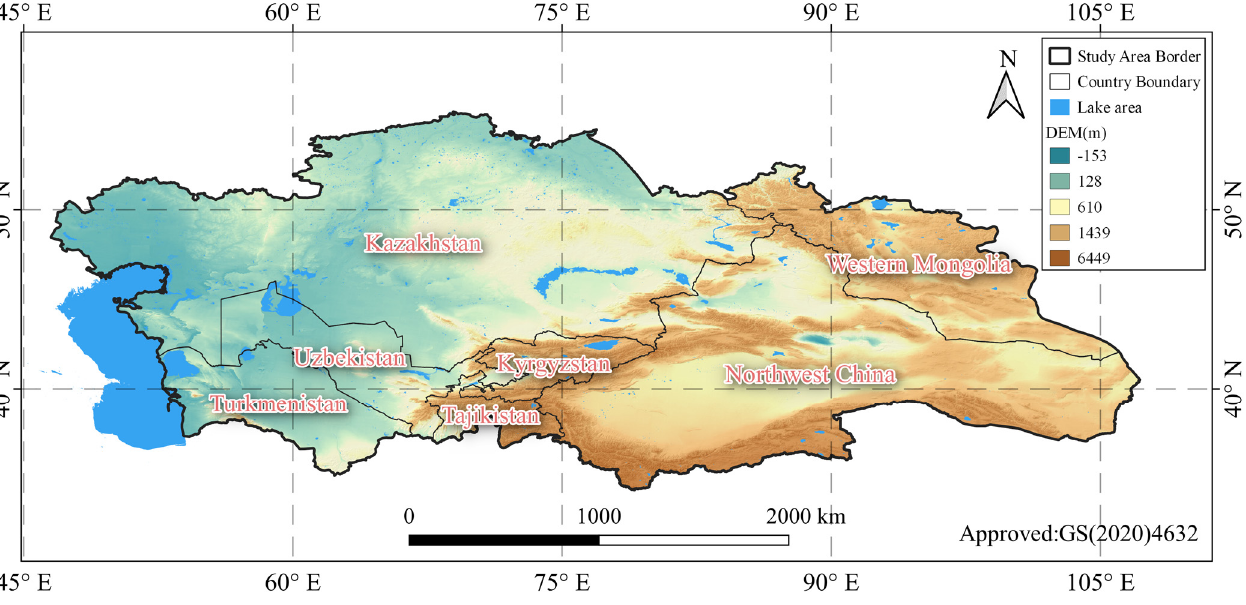
Figure 1. Digital Elevation Model (DEM) of Central Asia. (Note: the base map is made based on the standard map (GS(2020)4632) approved by the National Bureau of Surveying and mapping geographic information, and the base map is not modified.)